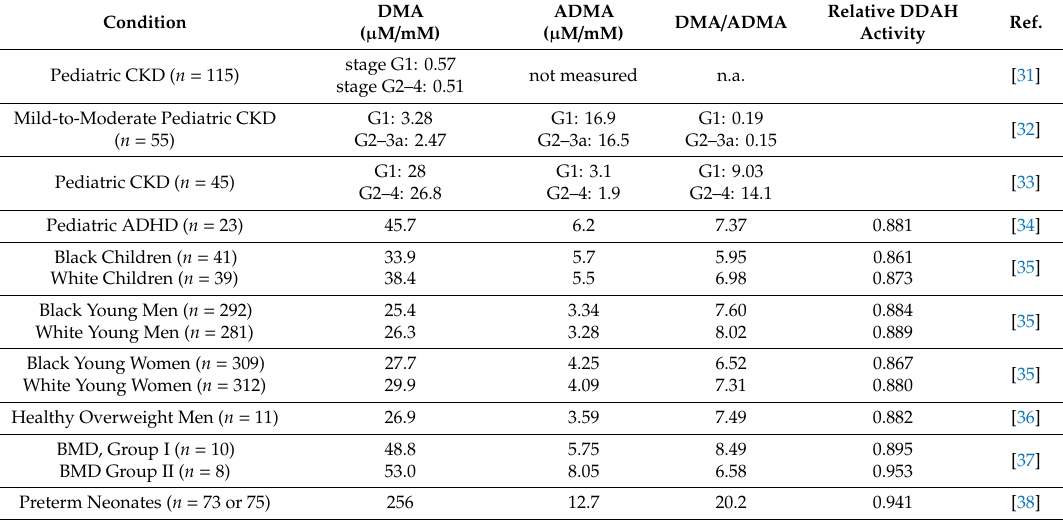
Table 1. Summary of reported creatinine-corrected urinary excretion rates of asymmetric dimethylarginine (ADMA) and dimethylamine (DMA) and of calculated DMA/ADMA molar ratio and the relative whole-body dimethylarginine dimethylaminohydrolase (DDAH) activity ((DMA/(DMA+ADMA)) in several conditions in humans.